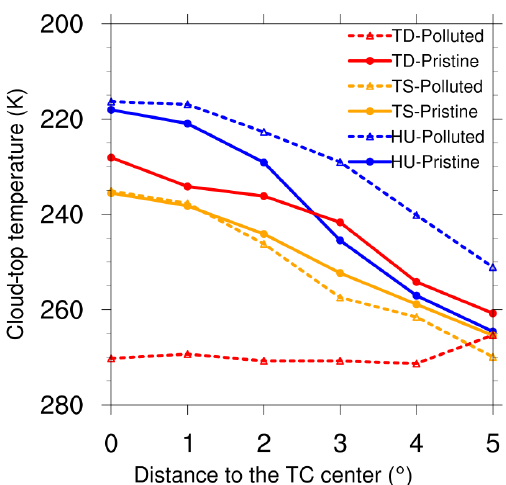
Figure 9. The radial distributions of CTT under pristine and pol- luted conditions of the composite TD, TS, and HU,